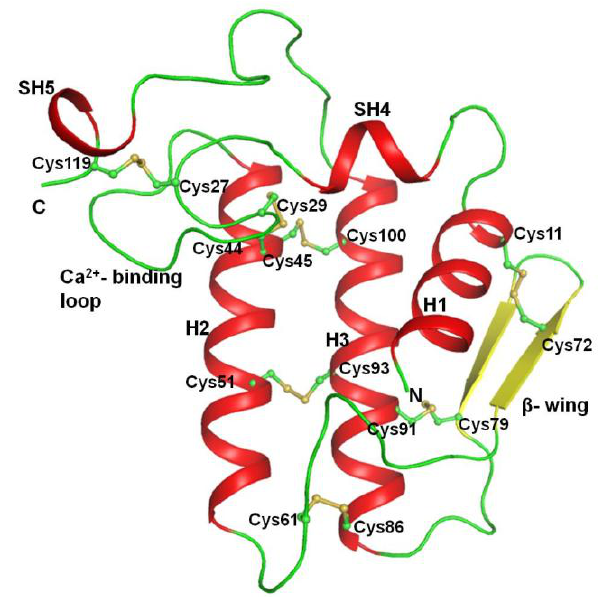
Figure 2. A ribbon diagram showing the overall structure of PLA shown in red, β strands colored yellow and disulfide links shown in ball and stick, colored green and yellow. The three main helices are indicated as H1, H2 and H3, while two short helices are designated as SH4 and SH5. β wing, calcium-binding loop and disulfide linkages are also